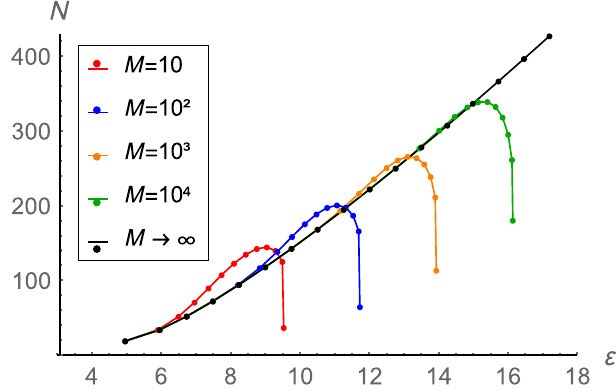
FIG. 6. The accuracy N as a function of the energy dissipation = ¯ t (with ½ ε (cid:2) ¼ E rate ε ¼ Q s − 1 ) for different numbers of C out horizontal extensions M , with c ¼ 10 5 s − 1 . As M increases, the maxima of the curves obtained by varying d are shifted toward higher values of N and ε , i.e., up and to the right, reaching finite values (not shown) in the limit M → ∞ (black curve). The individual peaks obtained for a given coupling strength c and number M of horizontal extensions correspond to the clocks that achieve maximal accuracy under these constraints. We exclude suboptimal cases, i.e., cases where increasing d reduces reso- lution and